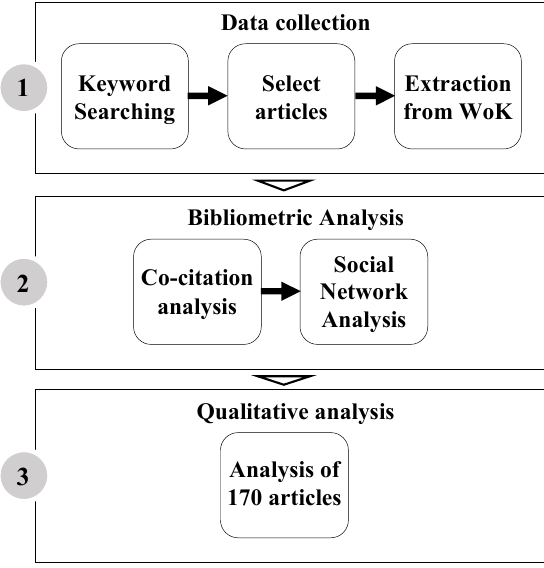
Figure 2. Main stages of the research.